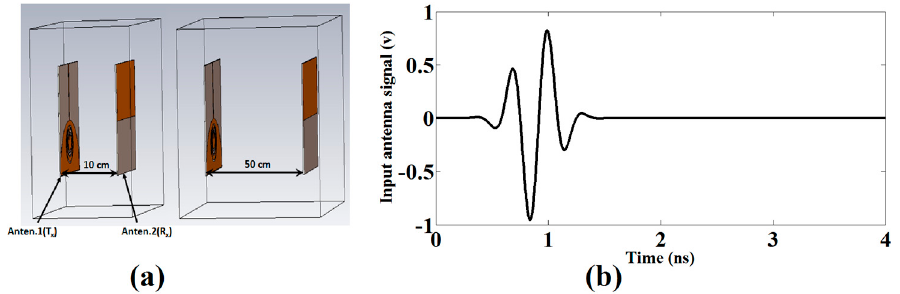
Figure 7. ( a ) Setup of the proposed antenna at two different distance ( b ) Input pulse selected for the excitation of the proposed antenna.